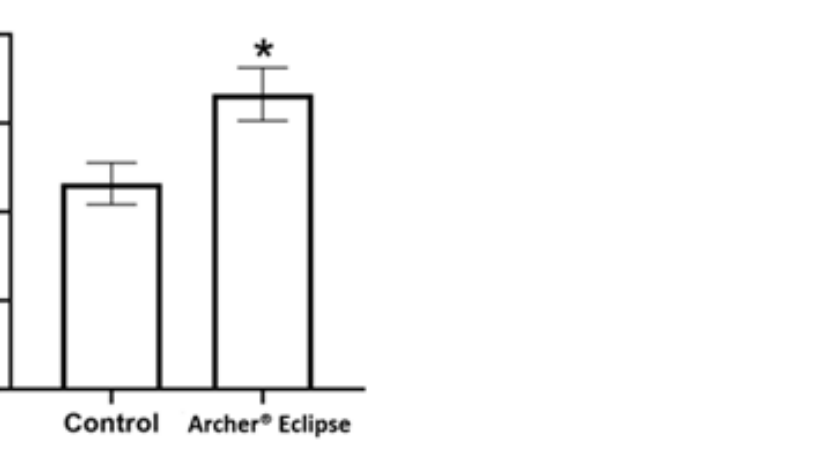
Figure 1. Appearance of leaves in the different treatments, in sampling days, after the application of sunburn-inducing conditions.